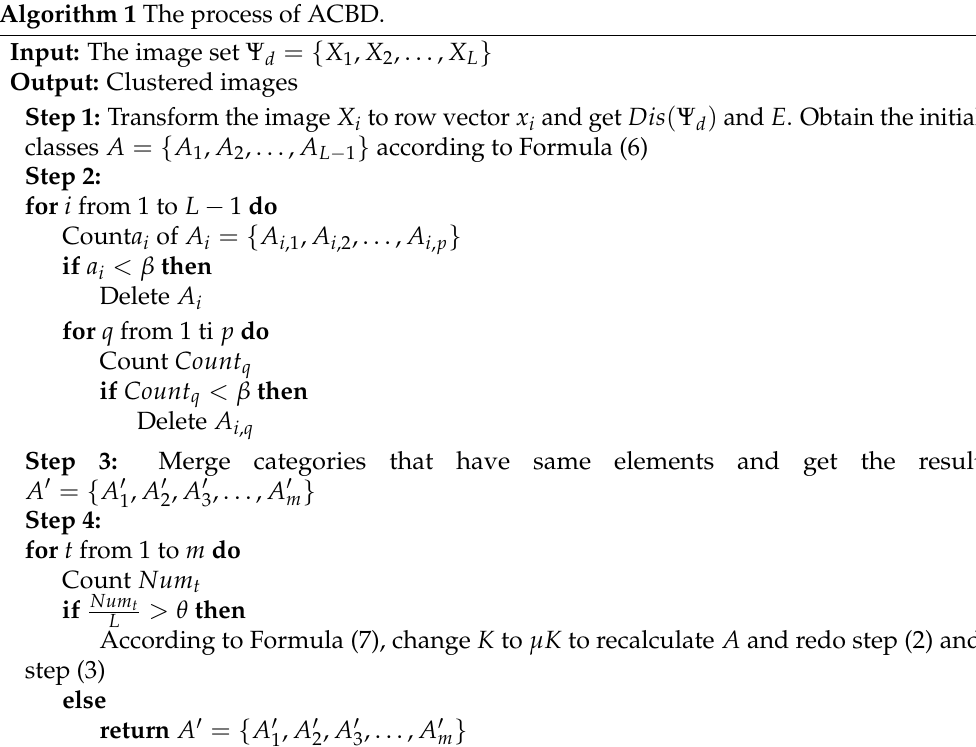
Algorithm 1 The process of